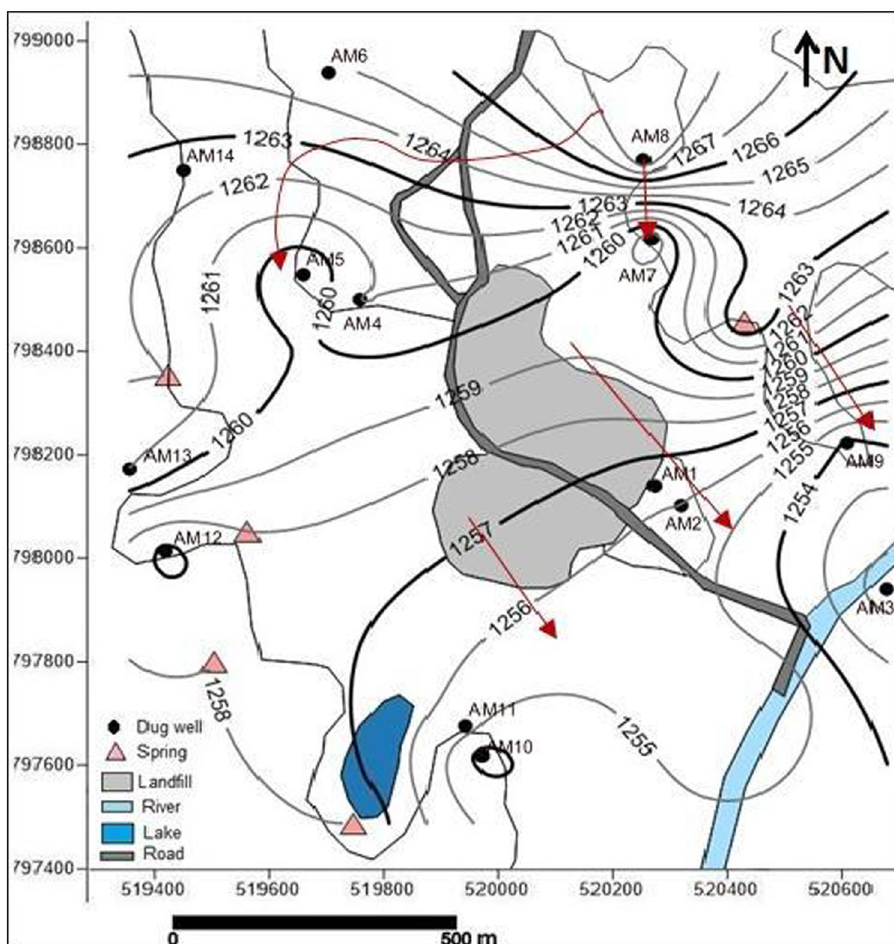
Fig. 3 Hydroisohypses map of the study